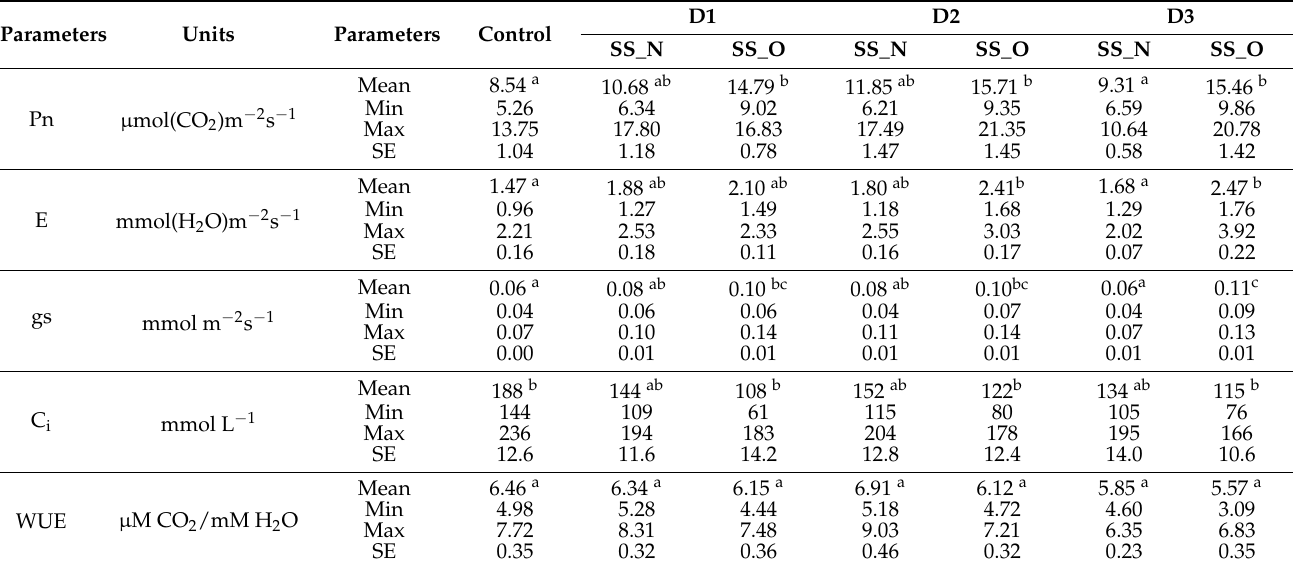
Table 5. Gas exchange parameters in maize plants depending on the sewage sludge dose and type. Mean values ( n = 9) ± standard error. Identical superscripts denote no significant ( p > 0.05) differences between the experimental variants according to the post hoc Tukey HSD